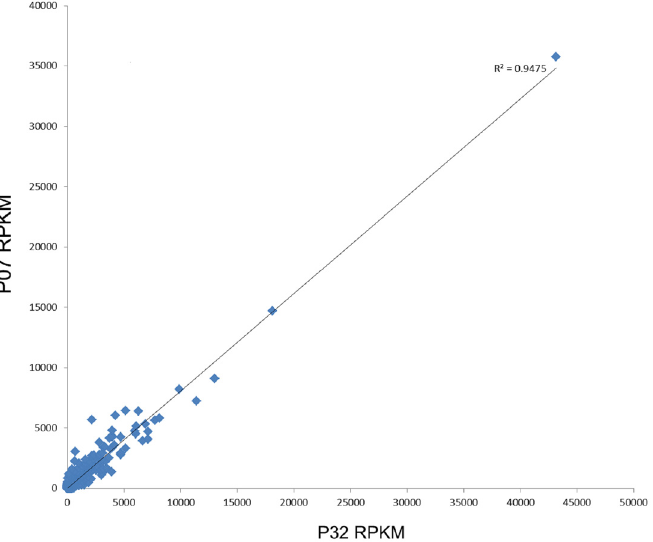
Fig 2. R 2 linear regression of the RNA-Seq data from both OE lines (P07 and P32). The R 2 values were calculated using the Sigma Stat package based on the RPKM values derived from RNA-Seq data and after eliminating genes with zero